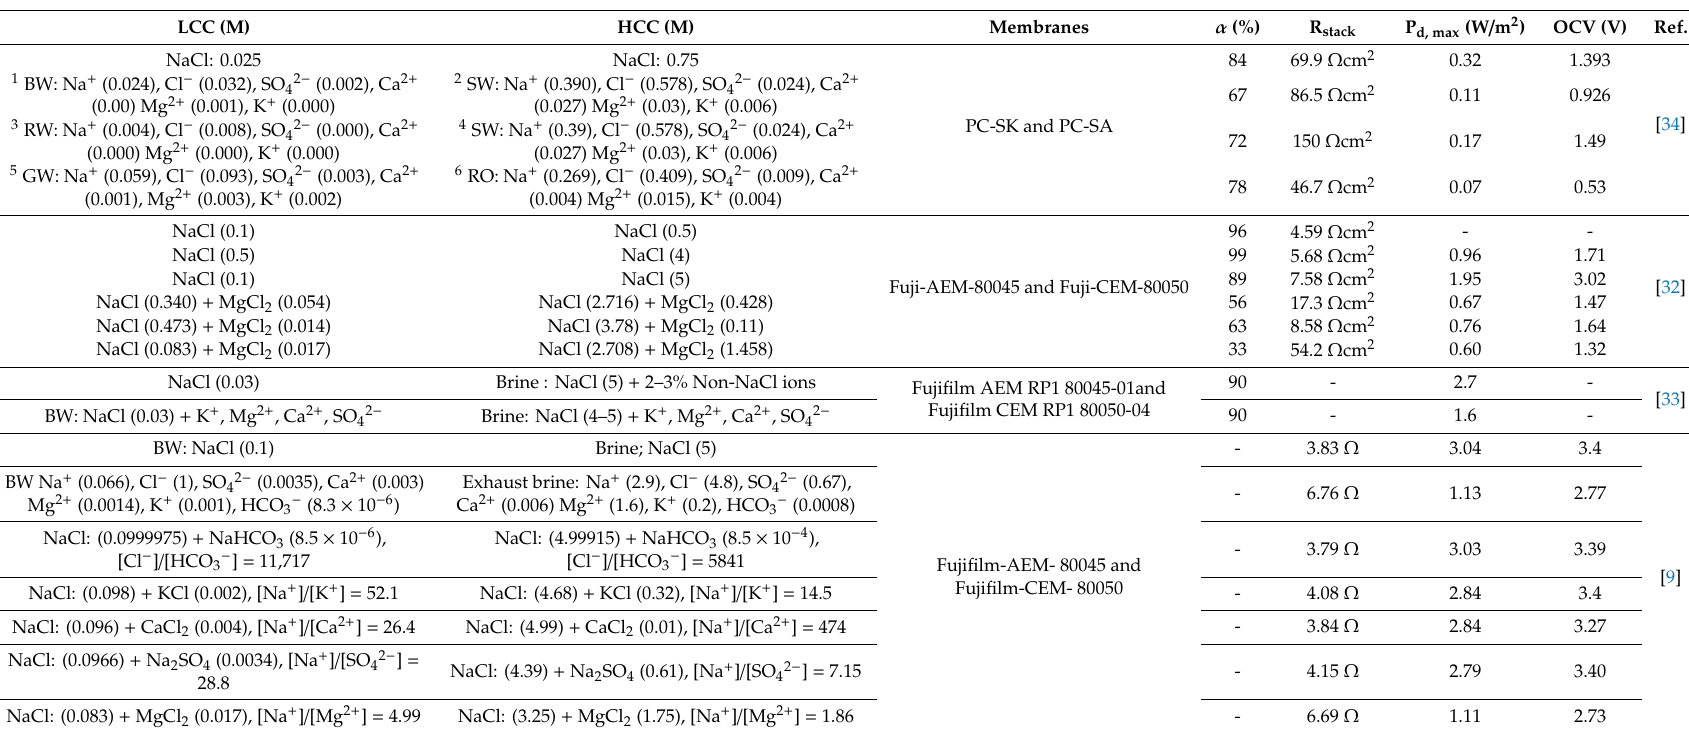
Table 1. The impact of divalent ions on the performance of RED under low and high feed salinity